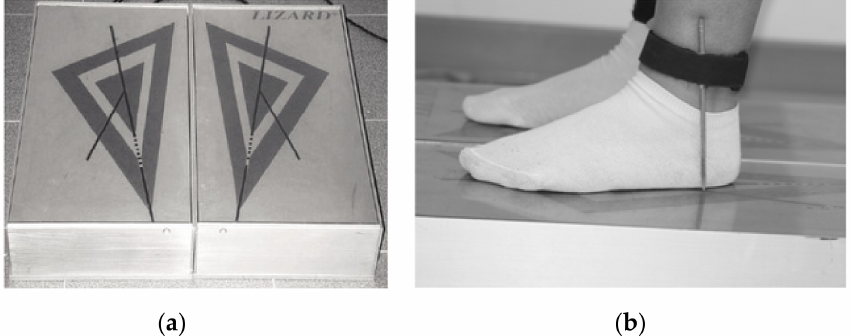
Figure 2. ( a ) Posture-stabilometric vertical force platform (Lizard; Lemax s.r.l., Como, Italy); ( b ) a custom tool for correct positioning of the subject on the